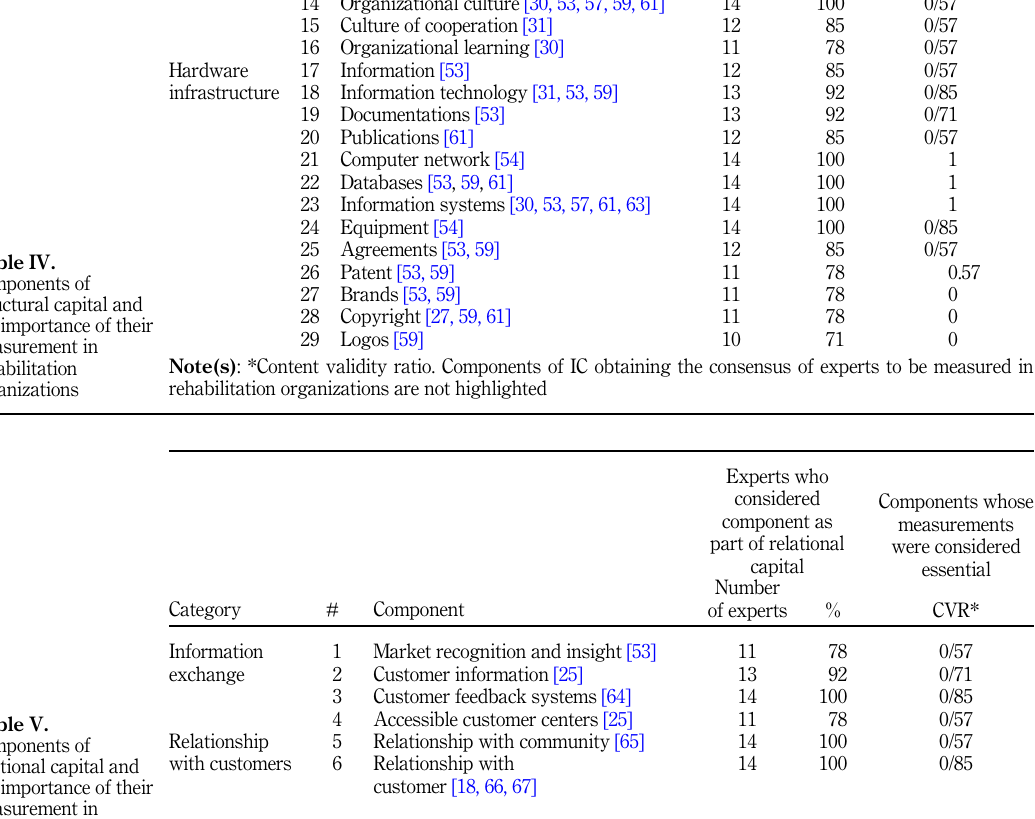
Table V. Components of relational capital and the importance of their measurement in rehabilitation